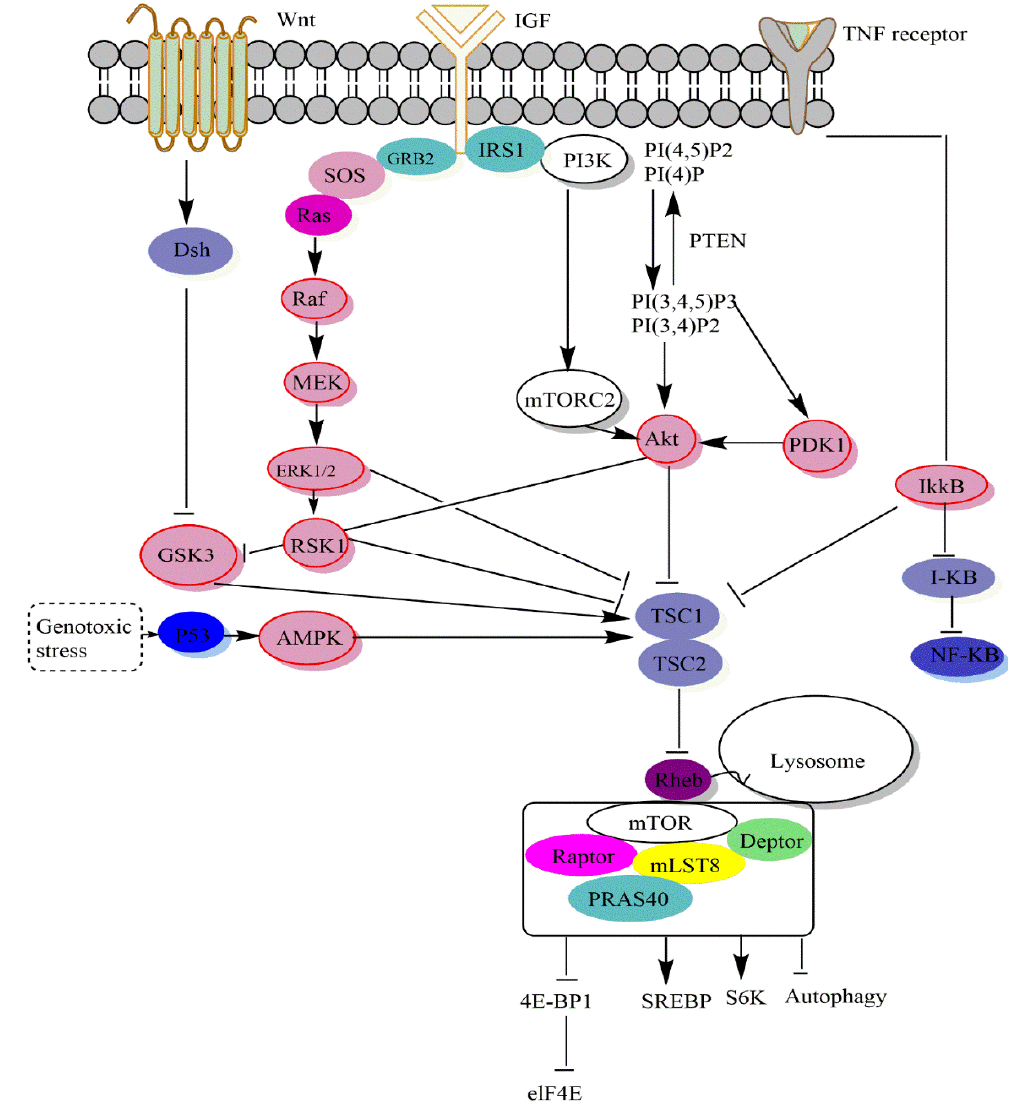
Figure 2. The mTOR pathway. mTORC1, also known as the rapamycin-sensitive complex, is made up of four proteins: mTOR, raptor, mLST8, and PRAS40. TSC1/2-Rheb is mTORC1’s primary upstream regulator. mTORC1 regulates protein translation by phosphorylating S6K1 and 4EBP1 via the TSC1/2- Rheb axis, which integrates cellular energy levels, growth hormones, and Wnt signals. Rheb, TSC1/2, AMPK, Rag, and Akt are the key upstream regulators of mTORC1. When mTORC1 is active at the lysosome membrane, it phosphorylates 4E-BP1, S6K, SREBP, and some autophagy components, all of which influence protein synthesis, lipid and lysosome production, energy metabolism, and autophagy. On the other hand, little is known about mTORC2’s upstream